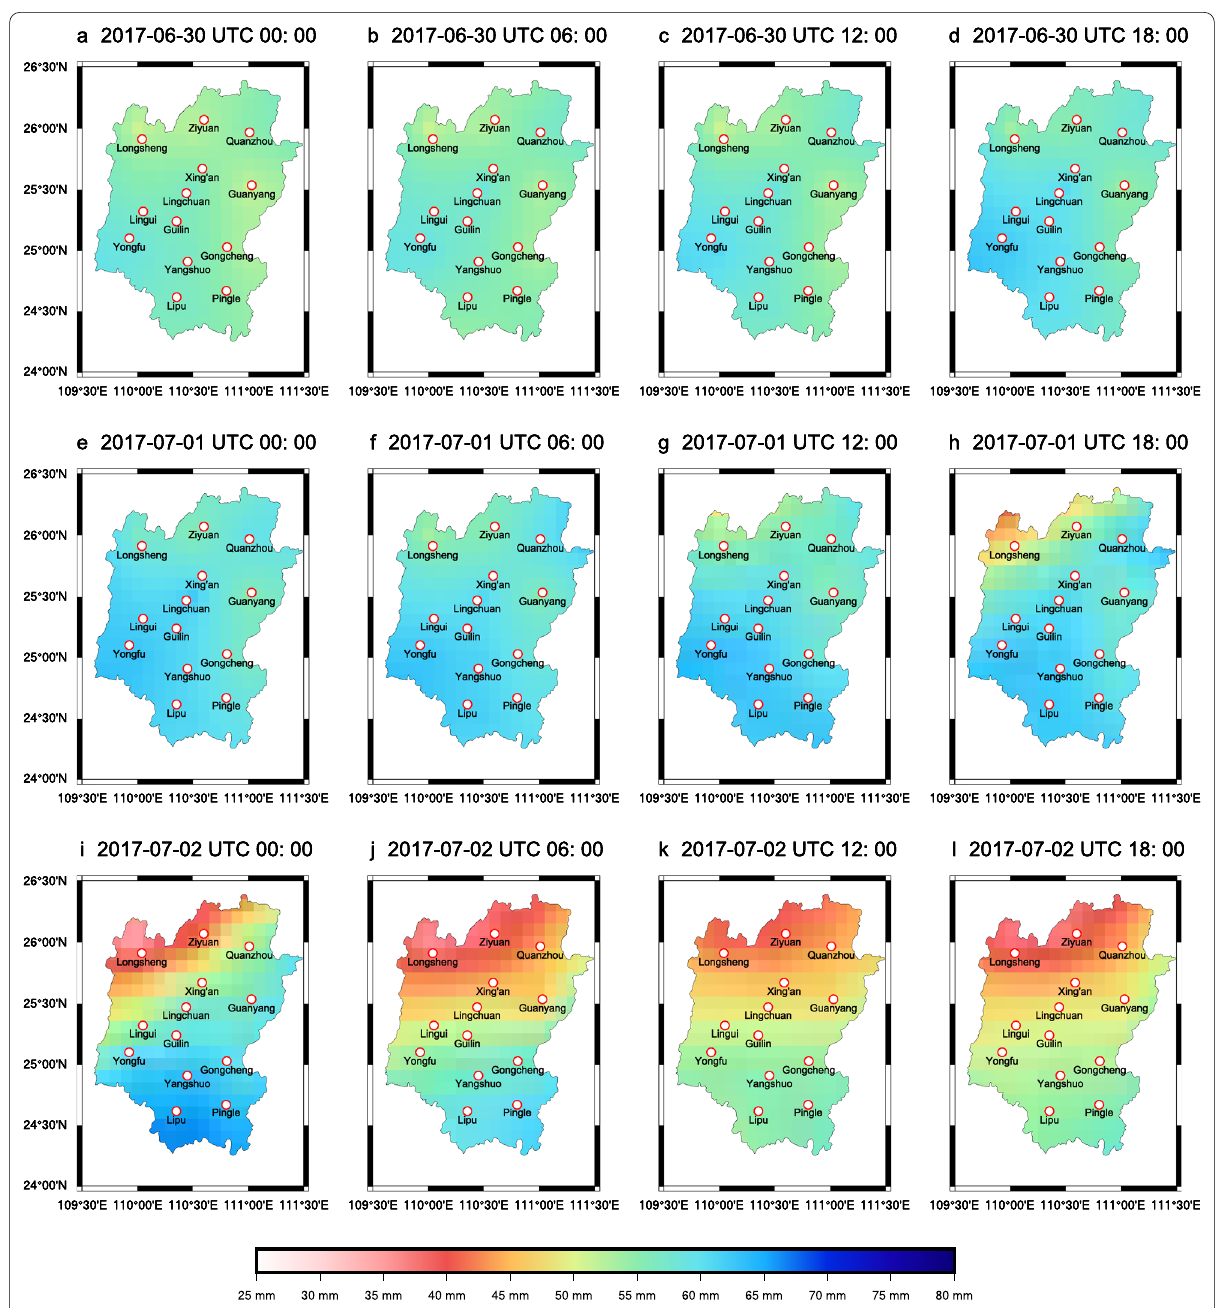
Fig. 11 Spatial evolution of ERA5 PWV for Guilin every 6 h from June 30 to July 2,